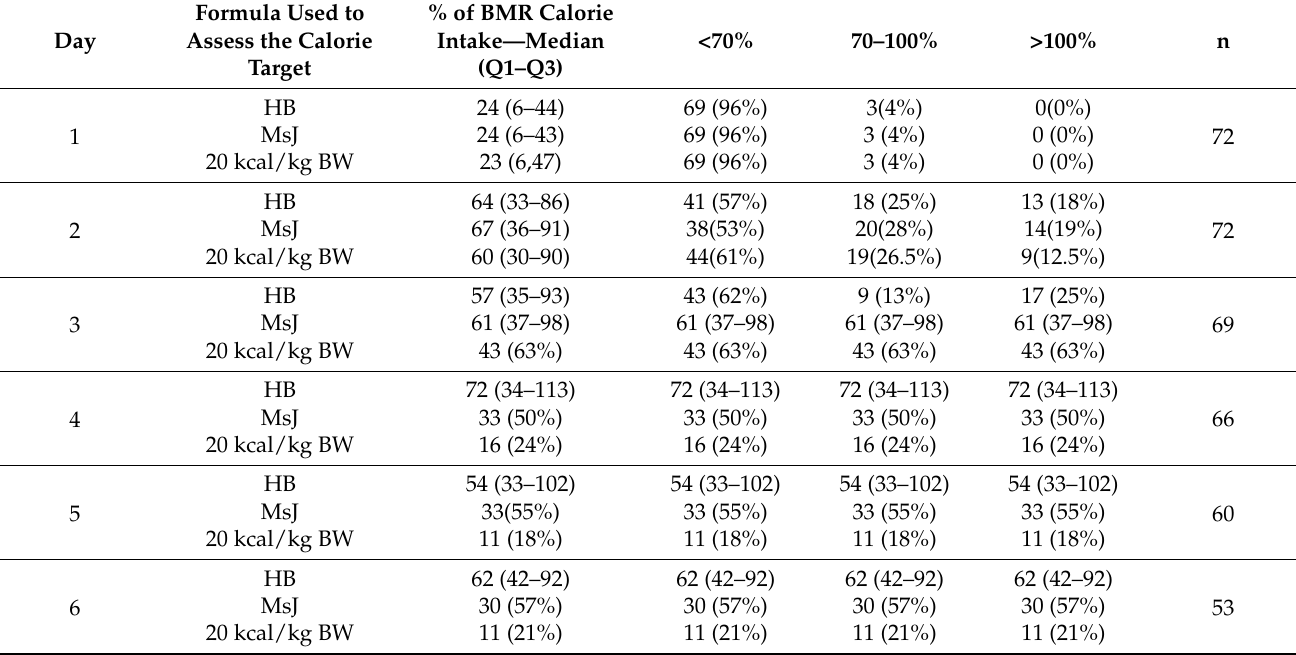
Table 2. Energy delivery in the ICU (days 1–7), according to subsequent formulas used to assess the calorie